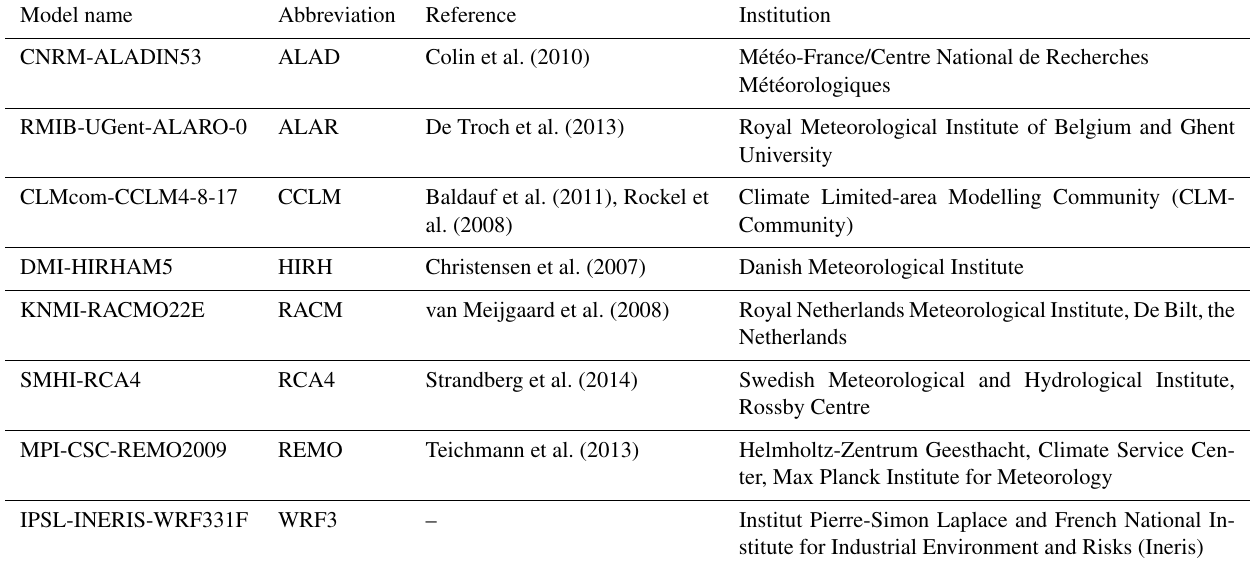
Table 3. List of RCMs, together with the abbreviations used in this paper, included at least once in the EURO-CORDEX